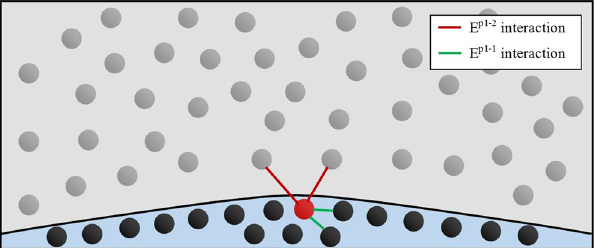
Figure 1. A Schematic of the interface between a molten iron droplet (black particles) and a molten oxide suspension medium (grey particles). An Al atom is present at the interface (red) with examples of inter (E P1-1 ) and intra (E P1-2 ) phase interactions